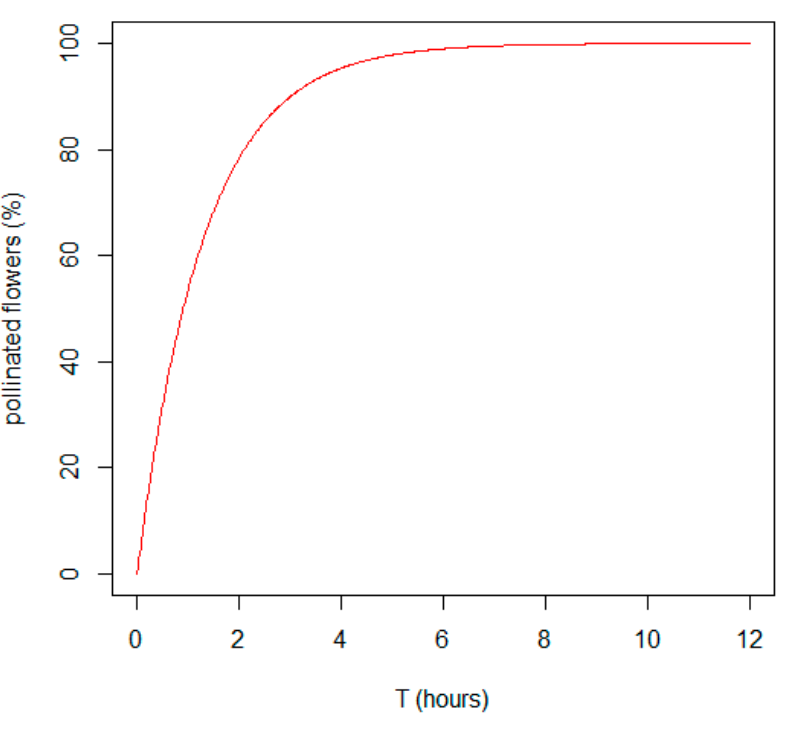
pollination in nonlinear way, with parameters τ s = 24 s, τ h = 60 s, M = 700,000.